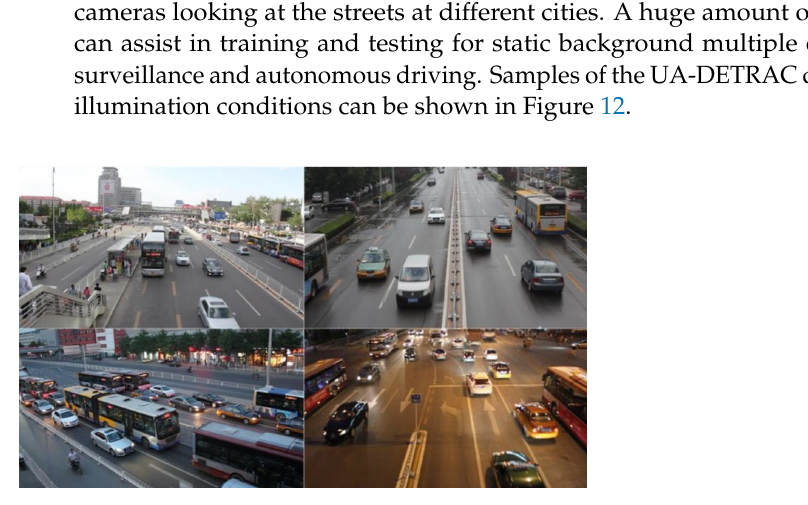
Figure 12. Samples of the UA-DETRAC dataset showing variation of illumination in the environment from a static